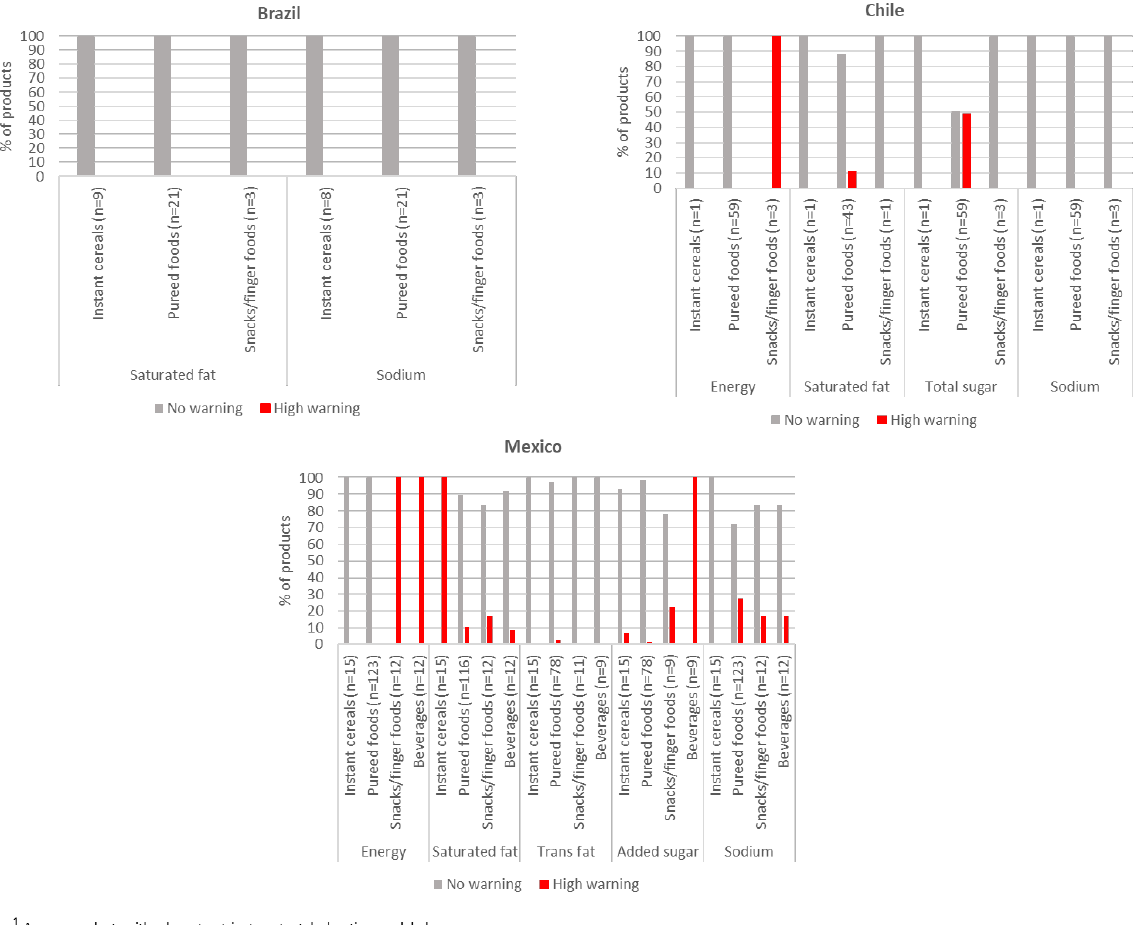
Figure 1. Proportion of commercially produced complementary foods warranting a warning sign 1